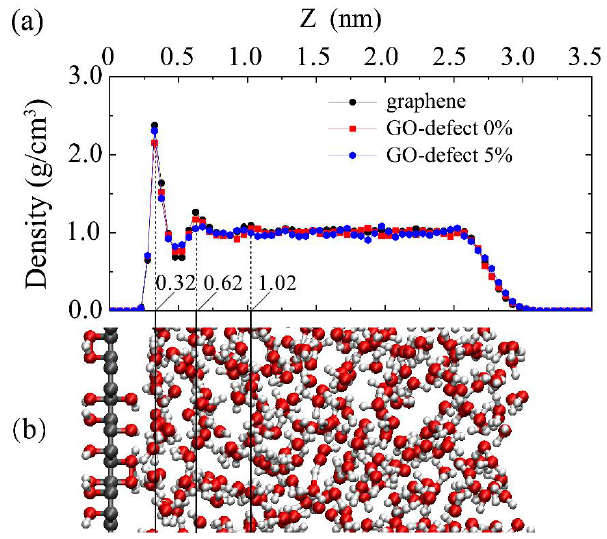
Figure 5. ( a ) Density profile along the GO sheet surface normal direction ( z -direction). ( b ) Water molecules distributions on GO surface for c = 0%.